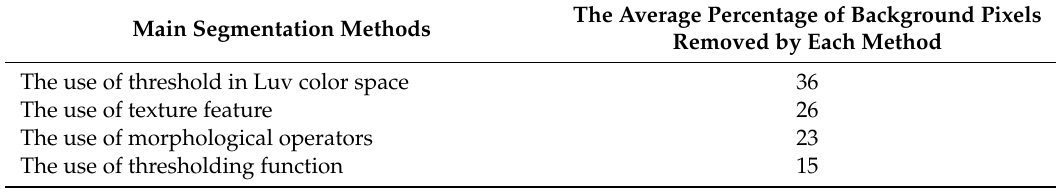
Table 4. The average percentage of background pixels removed by each segmentation method.